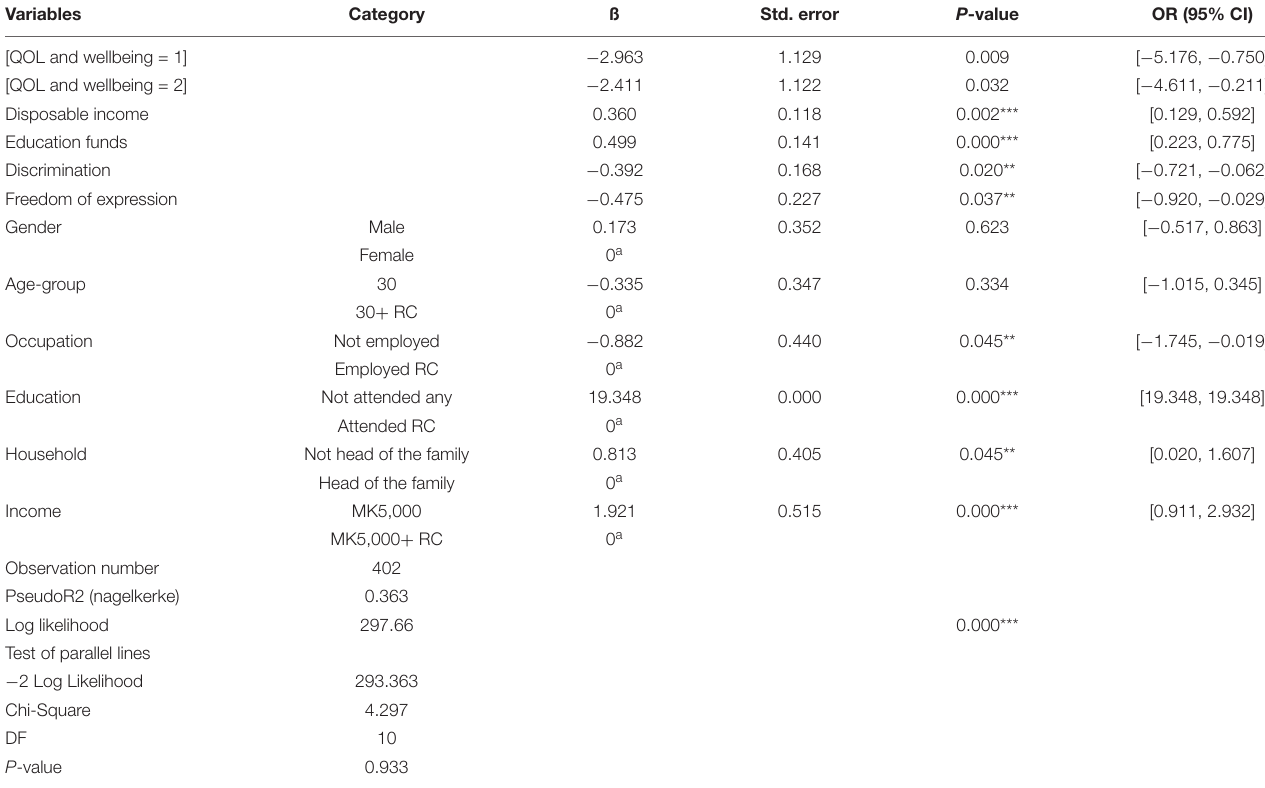
TABLE 6 | Associated factors and quality of life and wellbeing of respondents using ordinal regression model. Variables Category ß Std.